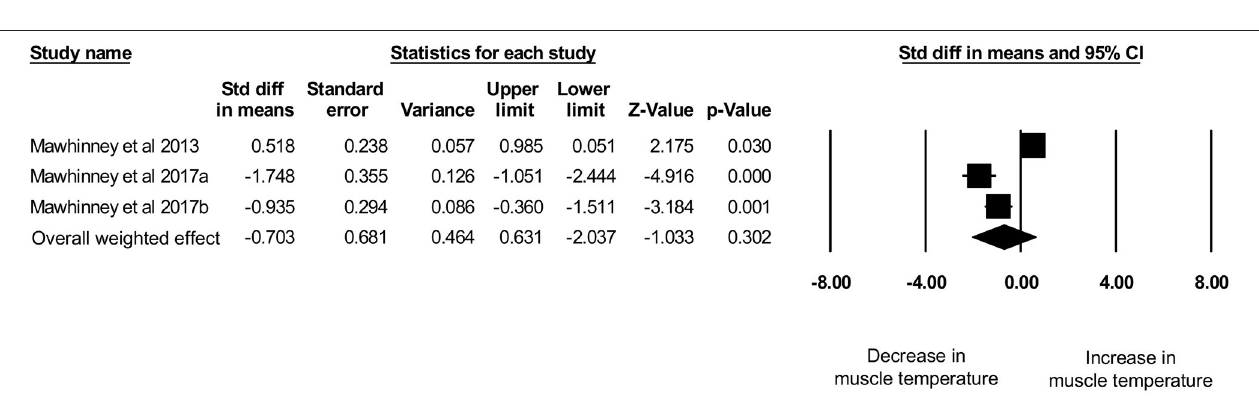
FIGURE 7 | Forest plot of the meta-analysis illustrating the comparison between baseline and post-exercise CWI temperature values at a muscle depth of